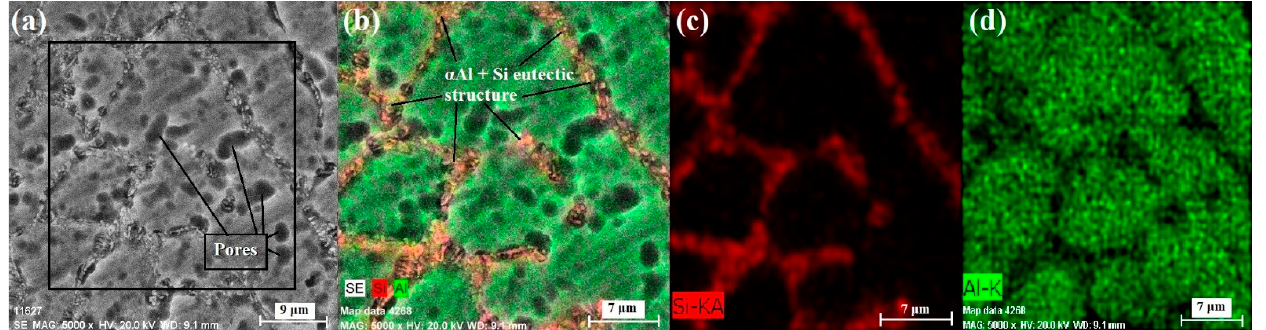
Figure 8. Sample “T” taken from the specimen build at a welding speed of 13.3 mm/s: ( a ) SEM micrograph of the studied zone; ( b ) EDX mapping; ( c ) silicon content detected; ( d ) aluminum content detected.